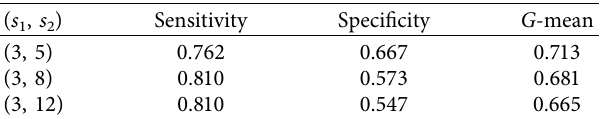
Table 2: Performance evaluation of the proposed method for